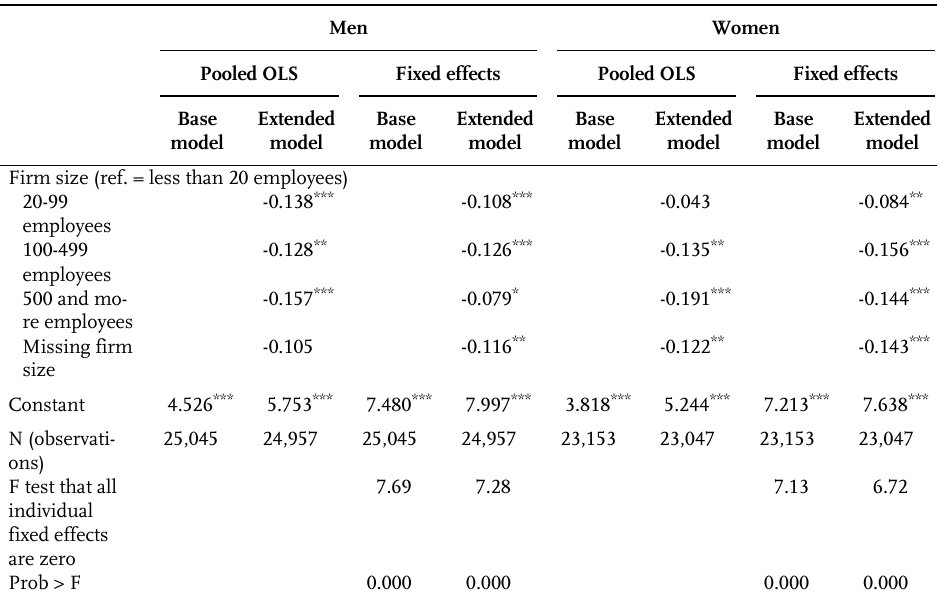
Table A.4 : Employment types and WFC (reflected scale) of parents with children aged 17 and younger (full models)